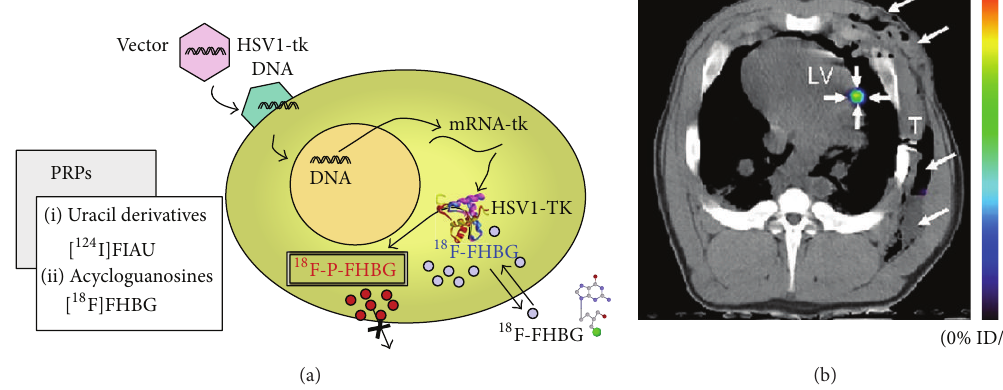
Figure 5: PET images of contrast agent-labeled stem cell. Panel (a) is the schematic of the indirect labeling using HSV1-TK and radioisotopes. Cells are transfected with HSV1-tk via vectors. 18 F-FHBG is phosphorylated by the enzyme which is encoded in the gene of the cell, and the reporter is consequently entrapped in the cell. Reproduced courtesy of Springer Publisher Group [95]. Panel (b) is a PET-CT image of MSCs that were labeled with a mutant HSV1-tk reporter gene. The cells were implanted into a swine and subsequently administrated with [ 18 F] FHBG. The PET-CT image provides both anatomical information (gray scale from CT) and the contrast of the implanted cells (color from PET data). Reproduced courtesy of Radiological Society of North America